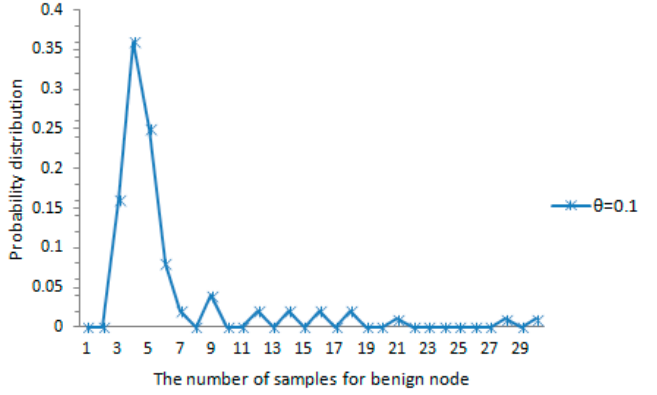
Figure 8. The probability distribution of the amount of samples for benign node.